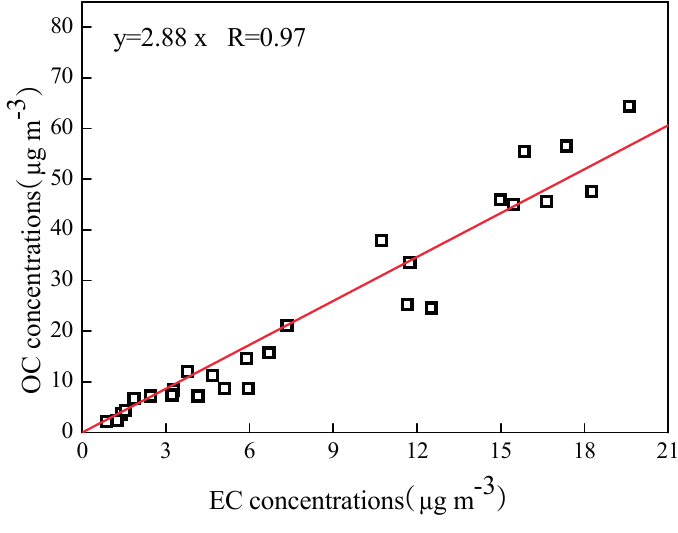
Figure 5. Relationships of OC and EC